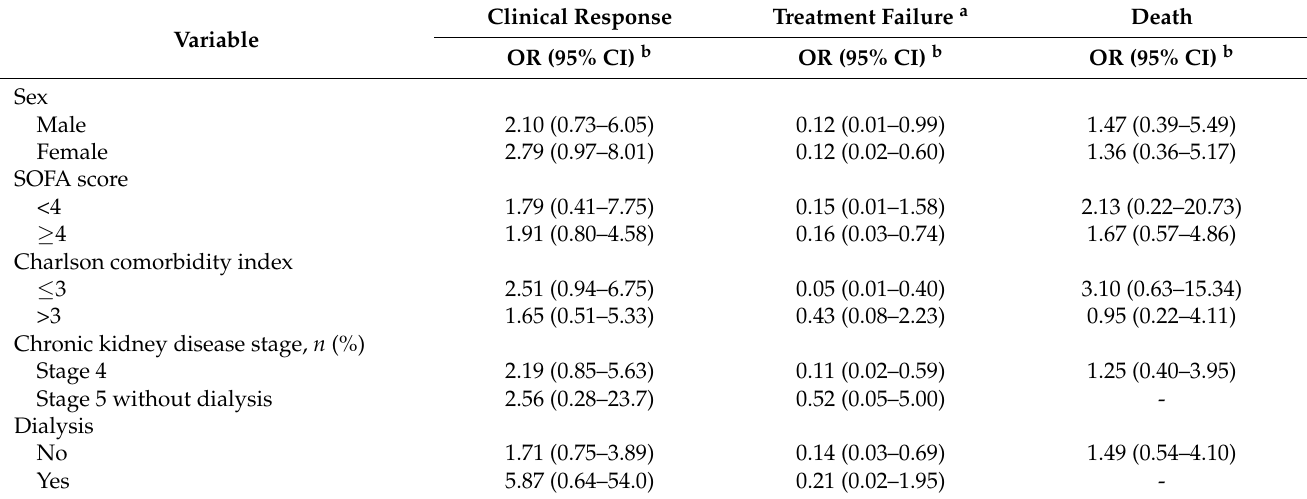
Table 3. Stratified